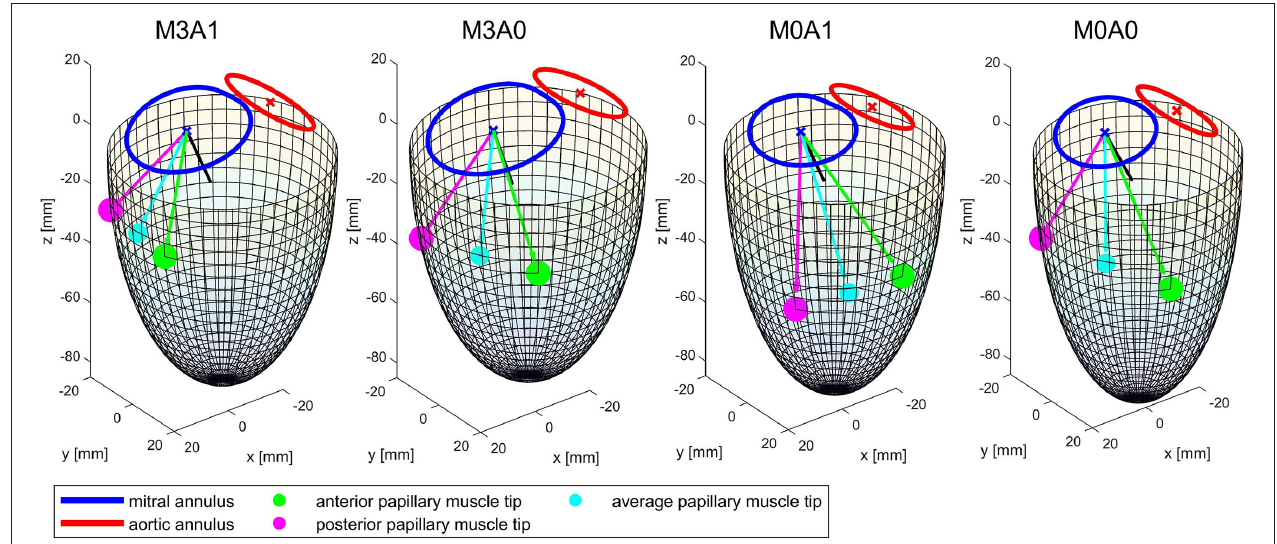
FIGURE 3 | Wireframe visualizations of the four representative cases at the end of systole. The papillary muscle tips are projected on the surface of the half-ellipsoid. The black line shows the vector normal on the mitral annulus plane. The cyan line and dot mark the average of the vectors connecting the papillary muscle tips with the center of the mitral annulus. It represents the direction of an averaged force of the chordae tendineae acting on the MV leaflets.